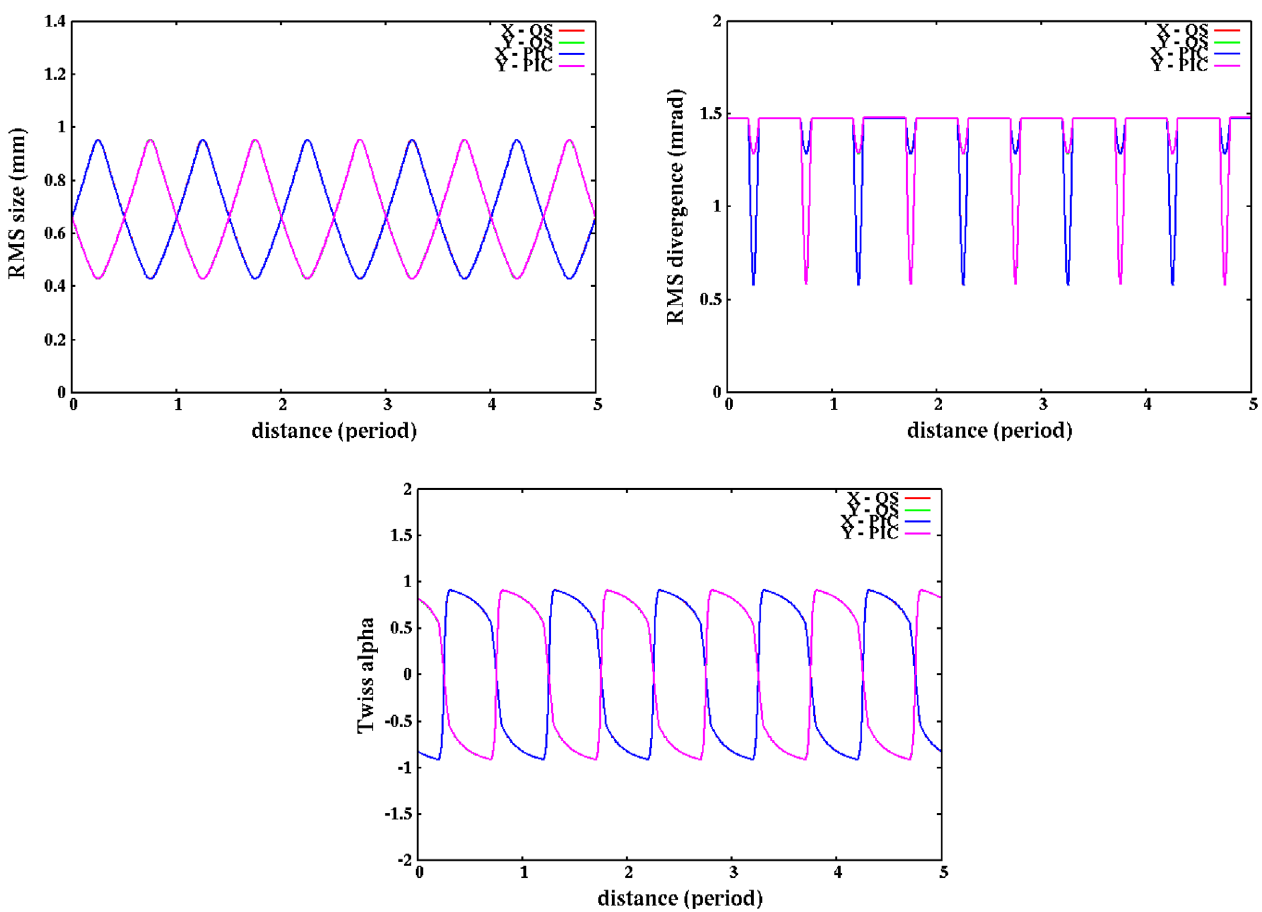
FIG. 2. Horizontal (x) and vertical (y) rms size (top left), rms momentum (top right), and beam Twiss alpha parameter (bottom) evolution through a five period FODO lattice from the quantum Schrödinger method (red and green) and from the PIC method (blue and magenta) without including the space-charge effects.